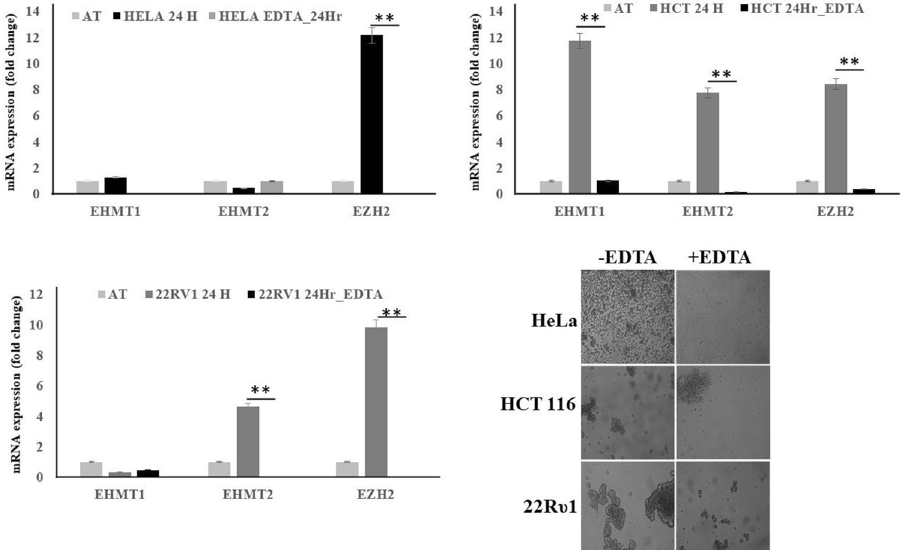
Figure 3. Cell clustering is critical for EZH2 induction during matrix detachment. All three endogenous cancer cells were grown in ultra-low attachment plates both in the presence and absence of EDTA for 24-h. Furthermore, after completion of the time point, R.N.A. was isolated, and quantitative-PCR was performed for targeted genes, values were normalized with housekeeping gene RPLP0. Bars depicting normalized data (mean ± S.E.M., n = 3), * P <